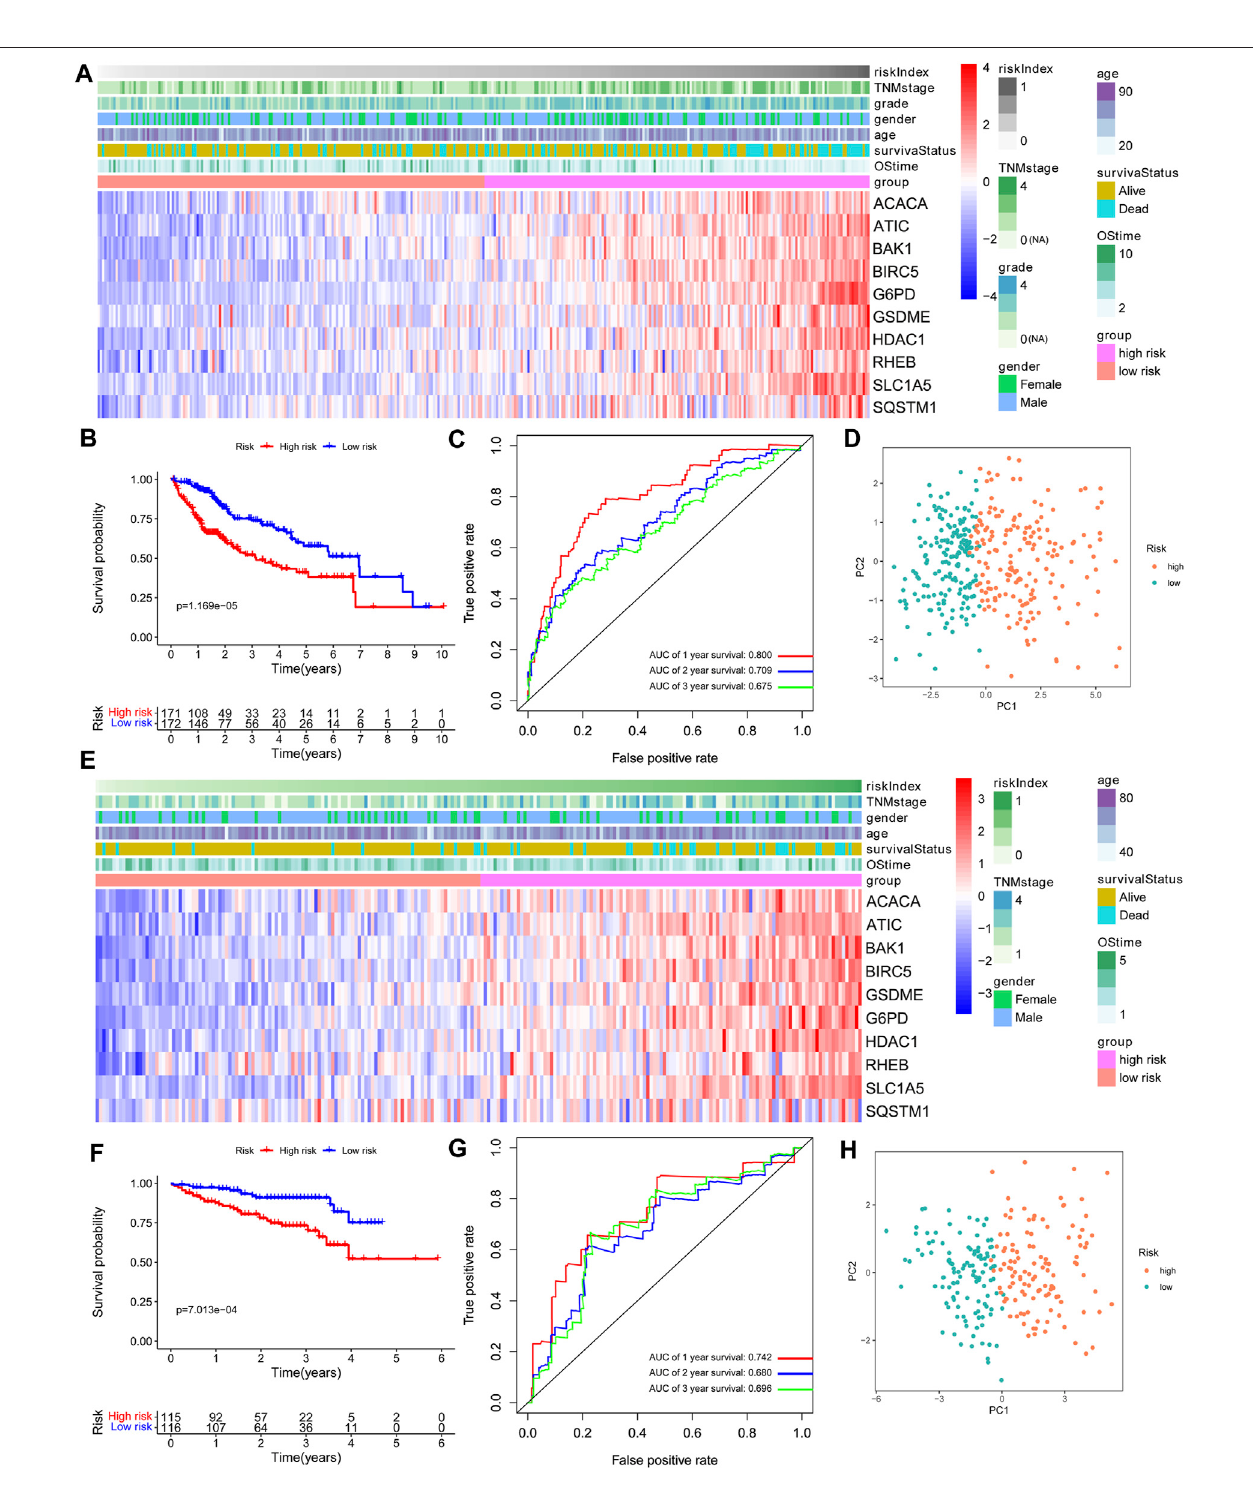
FIGURE 2 | Prognostic value of the 10-gene signature model. (A,E) The heatmap of clinicopathological features and 10 model-gene expressions between two subgroups. (B,F) Kaplan – Meier curves for OS of patients. (C,G) AUC of time-dependent ROC curves. (D,H) The results of PCA plot analyses. A – D: TCGA cohort. E – H: ICGC